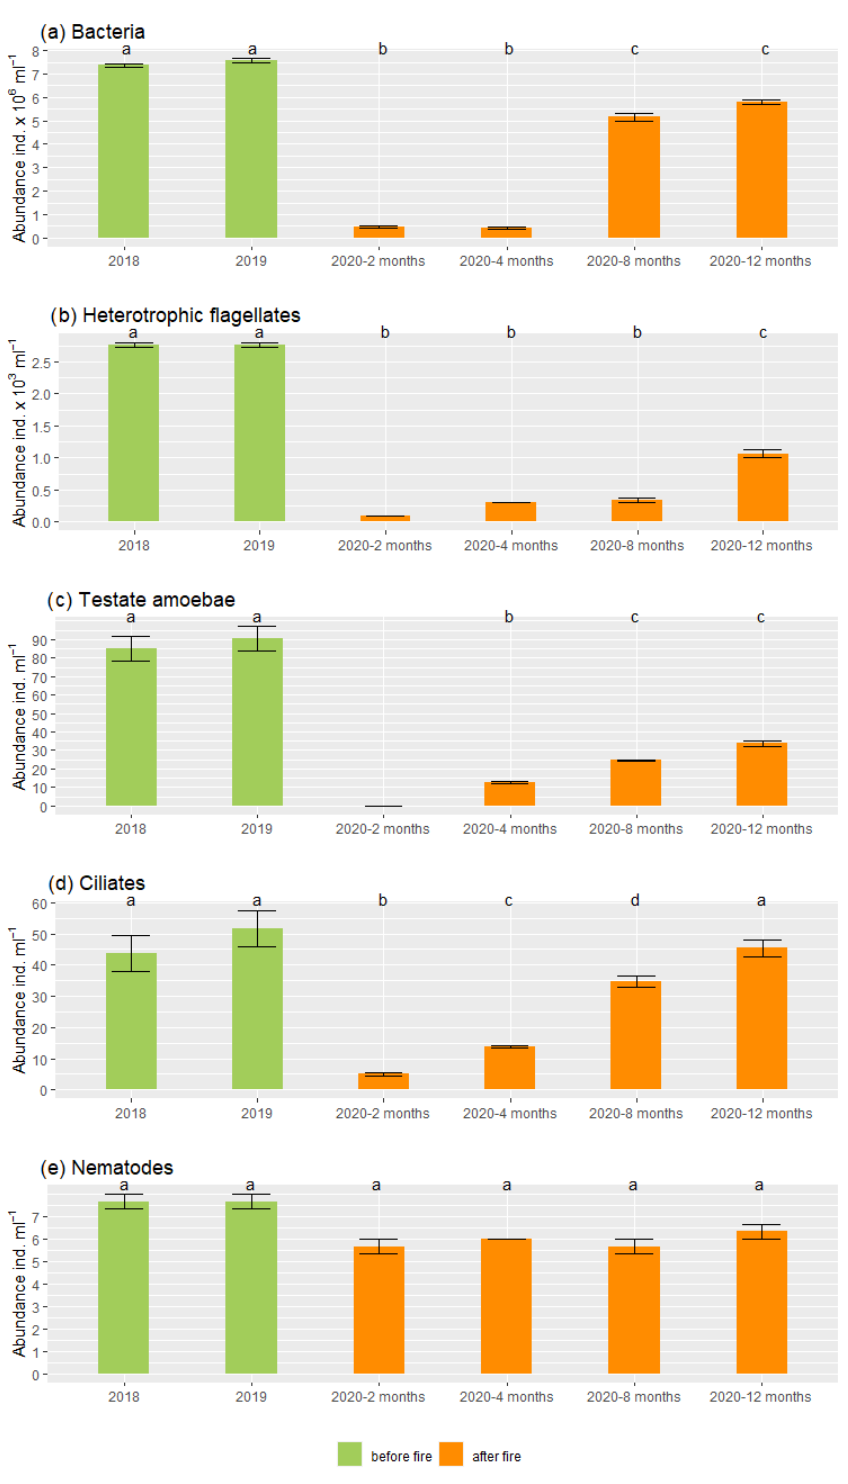
Figure 3. Barplot with error bars for abundance of ( a ) bacteria; ( b ) heterotrophic flagellates; ( c ) tes- tate amoebae; ( d ) ciliates; ( e ) nematodes before and after fire. Different letters above the bars indicate statistically significant difference.